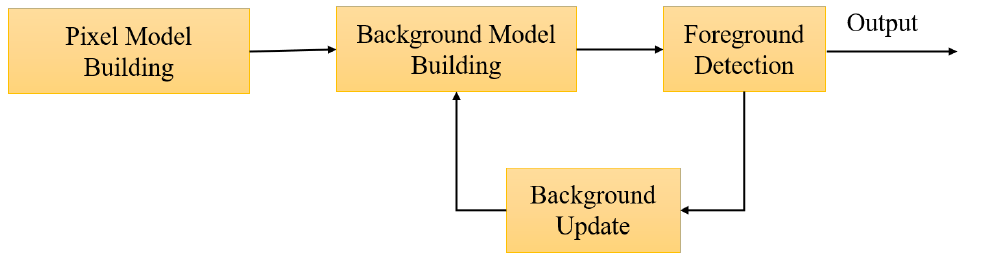
Figure 5. The construction diagram of pixel-background sample